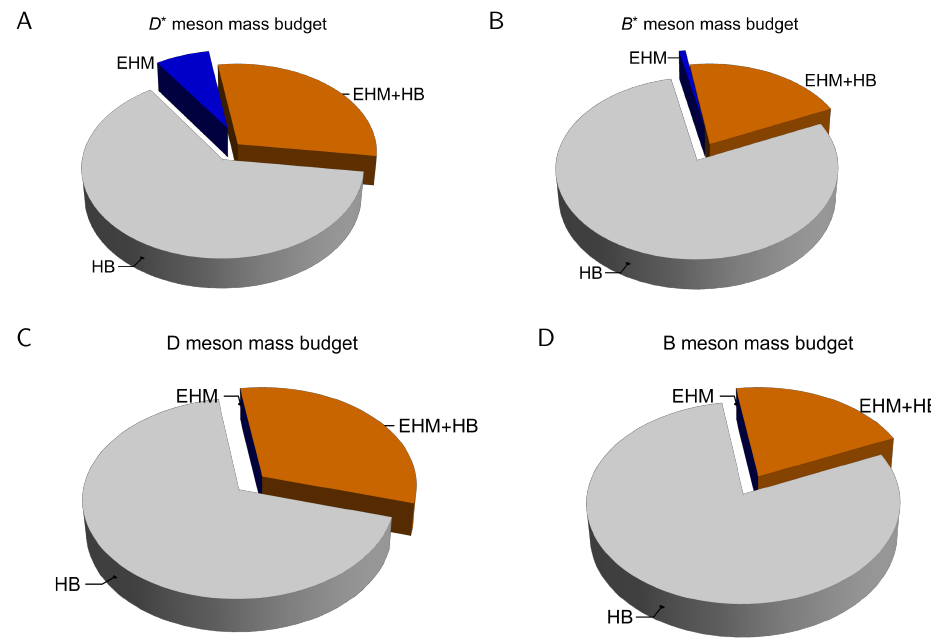
Figure 18. Mass budgets: ( A ): D ∗ meson; ( B ): B ∗ -meson; ( C ): D meson; ( D ): B meson. Each is drawn using a Poincaré-invariant decomposition and the numerical values listed in Table 1. (Separation at ζ = 2 GeV , calculated using information from References[35,40]).